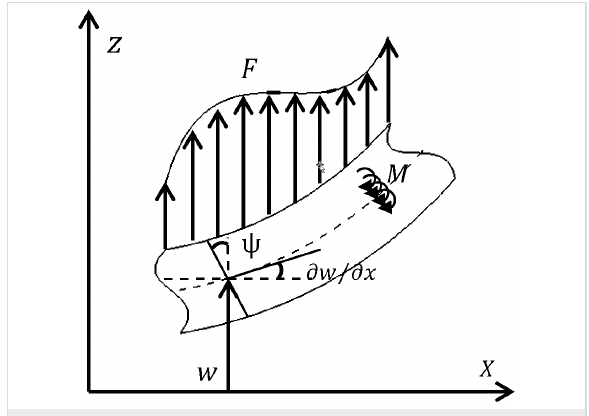
Figure 3: Timoshenko beam model: kinematic parameters, loading and coordinate system [27].